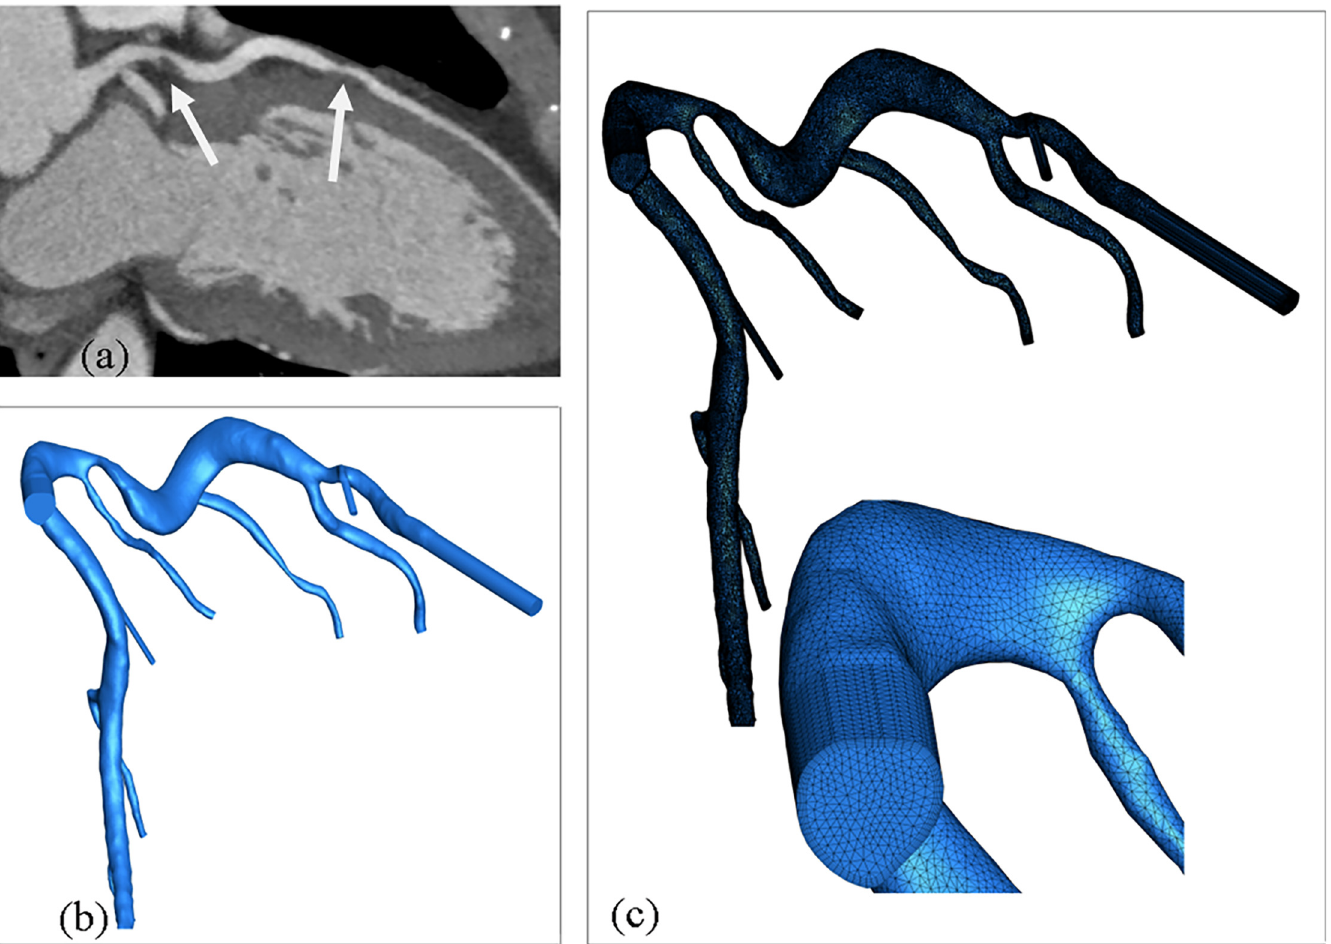
Fig 1. (a) Coronary CTA images for a 52-years-old man, which showed two stenoses (indicated by white arrows) along the left anterior descending artery (b) 3D coronary model reconstructed from CTA images and (c) meshes generated for this model with enlarged view of dense meshes assigned near the